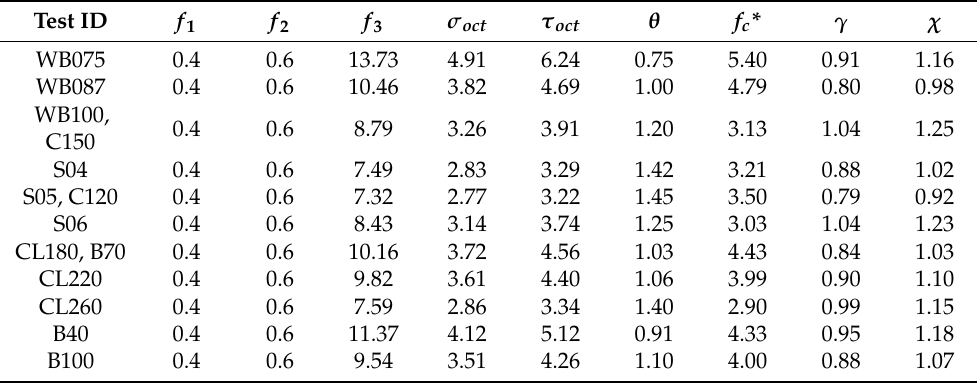
Table 8. Normal stress, shear stress and Lode’s angle in octahedral stress space under (0.4 MPa, 0.6